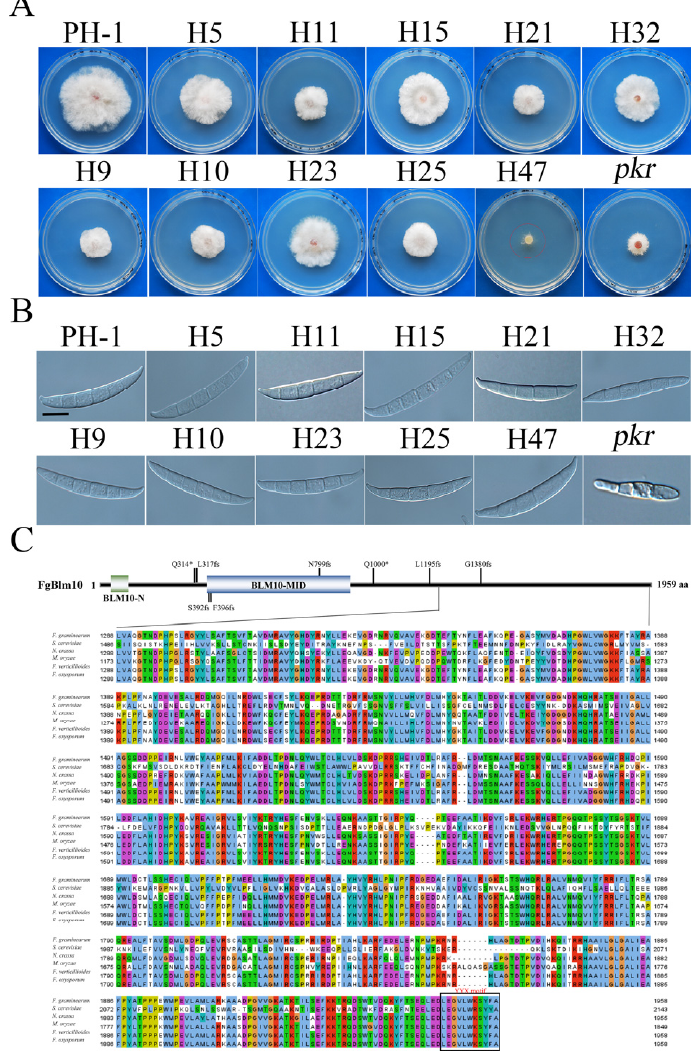
Figure 1. Suppressors of pkr with mutations in FgBLM10 and structural features of FgBlm10. ( A ) Three-day-old PDA cultures of the pkr mutant and marked suppressors with mutations in Fg- Blm10. ( B ) Conidia of the same set of strains from 5-day-old CMC cultures. Bar = 10 µ m. ( C ) Schematic drawing of the FgBlm10 protein and alignment of its C-terminal 1566-aa with orthologs from Fusar- ium graminearum (Fg), Saccharomyces cerevisiae (Sc), Neurospora crassa (Nc), Magnaporthe oryzae (Mo), F. oxysporum (Fo), and F. verticillioides (Fv). *, Stop codon; fs; frameshift mutant. 2.2. Deletion of FgBlm10 C-Terminus Partially Rescued Growth and Conidiation Defects of the pkr